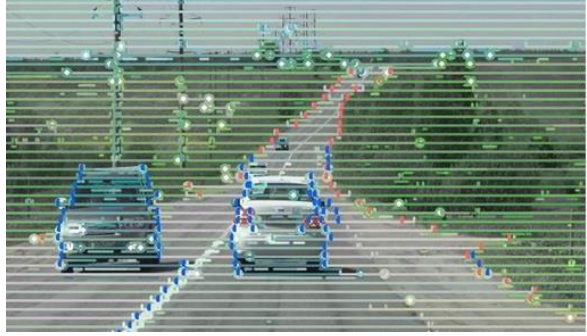
Figure 4 . Contours in the STG